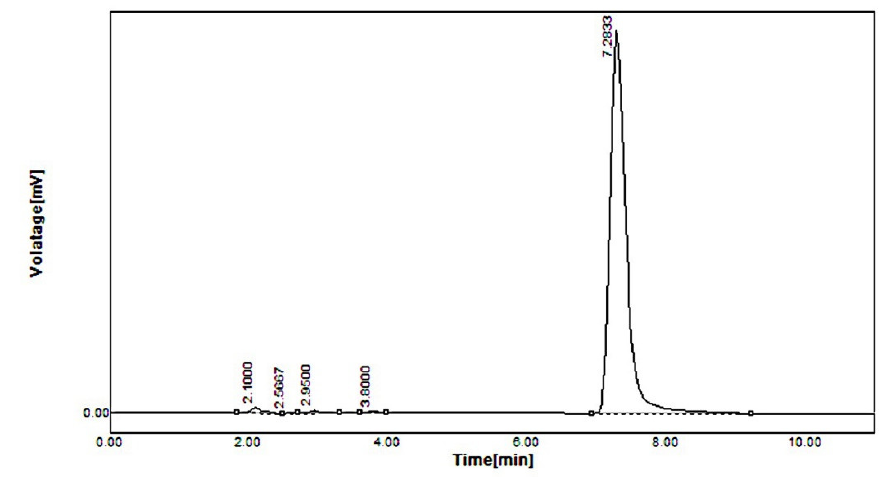
Figure 2. HPLC of standard simvastatin spiked in plasma.